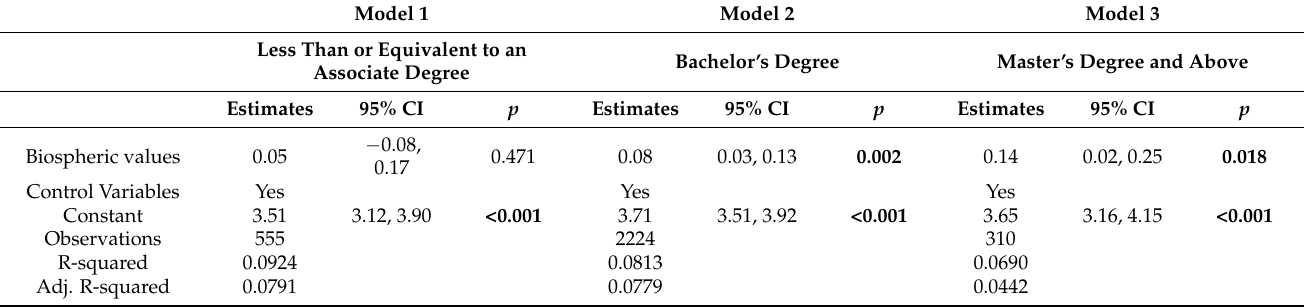
Table 9. Heterogeneous effect of education in the relationship of biospheric values and attitudes.